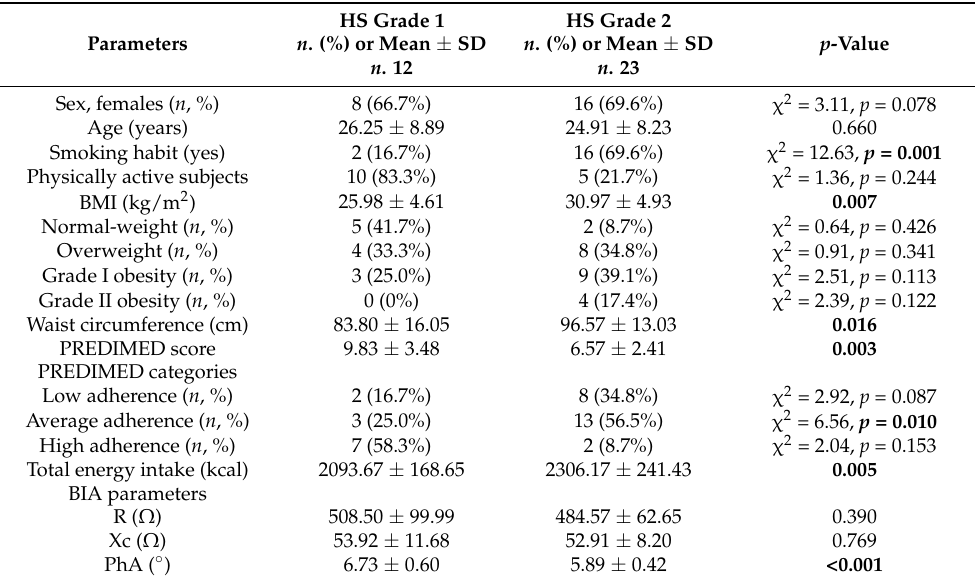
Table 2. Differences in the Hurley system in demographic characteristics, anthropometric measure- ments, nutritional assessments, and BIA parameters in HS patients.